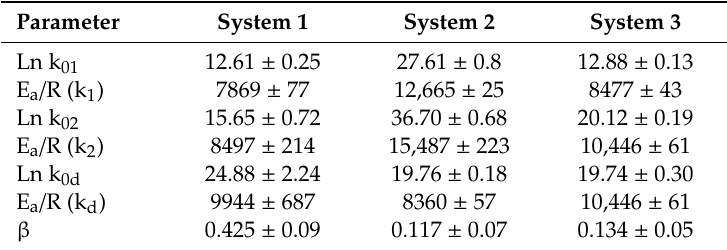
Table 4. Kinetic parameters for the model fitted to all data from acetone (system 1), MEK (system 2) and cyclohexanone (system 3) ketalization reactions with